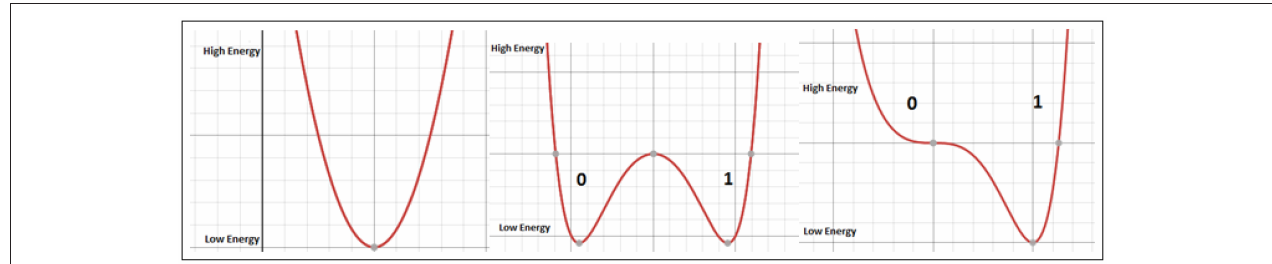
FIGURE 1 | (Left) Initial superposition represented by the minimum energy of the 1-qubit system. (Middle) Double-well potential caused by quantum annealing. (Right) Tilting of the double-well potential by the application of external magnetic